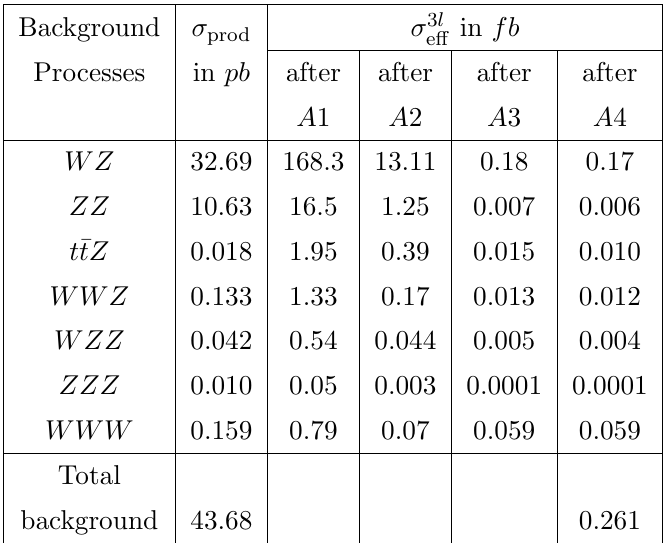
Table 8 . The production and e(cid:11)ective cross-sections ( (cid:27) 3 l